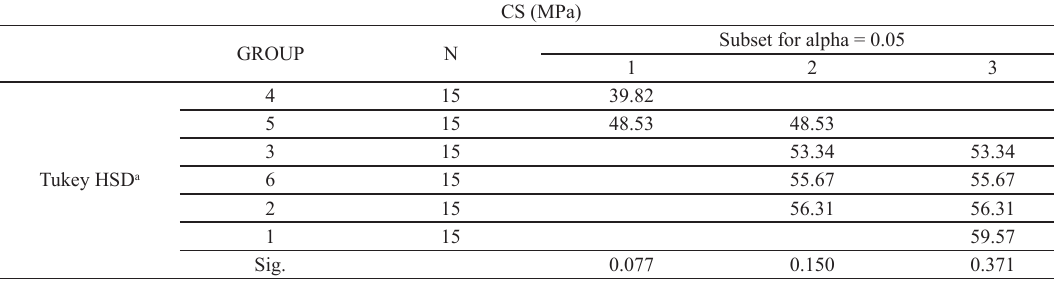
Table 3 - Means of compressive strength (CS) for groups in homogeneous subsets.